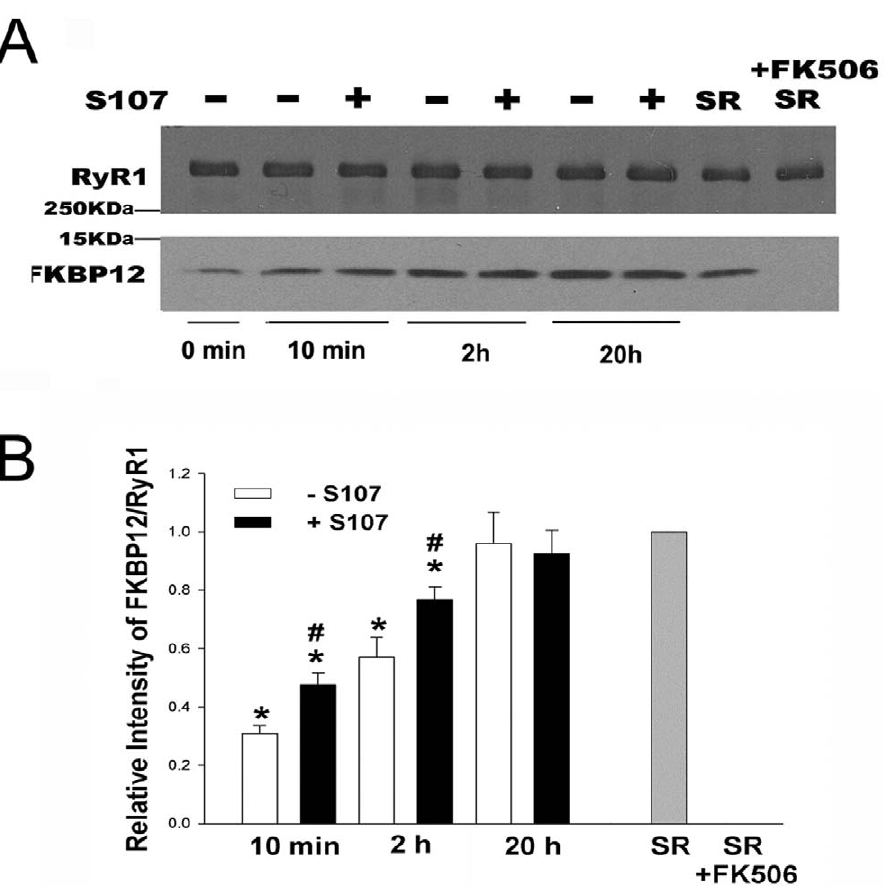
Figure 7. Time course of FKBP12 binding in the presence and absence of S107. (A) Immunoblots of RyR1 and FKBP12. SR vesicles treated with FK506 were incubated in 0.25 M KCl, 20 mM imidazole, pH 7.0, 7 m M free Ca 2 + , protease inhibitors and 1 m M FKBP12 for the indicated times in the presence of 5 mM GSH, and absence or presence of 44 m M S107. FKBP12 binding was stopped by centrifugation. (B) Data are the mean 6 SEM of 7 experiments. They were corrected for amounts of FKBP12 associated with FK506 treated SR vesicles kept on ice and normalized to SR vesicles not treated with FK506 (gray bar). *p , 0.05 compared to SR vesicles not treated with FK506 and not incubated with FKBP12 and S107. # p , 0.05 compared to FKBP12-depleted SR vesicles incubated for the same time (10 min or 2 h) in the presence of FKBP12 but absence of